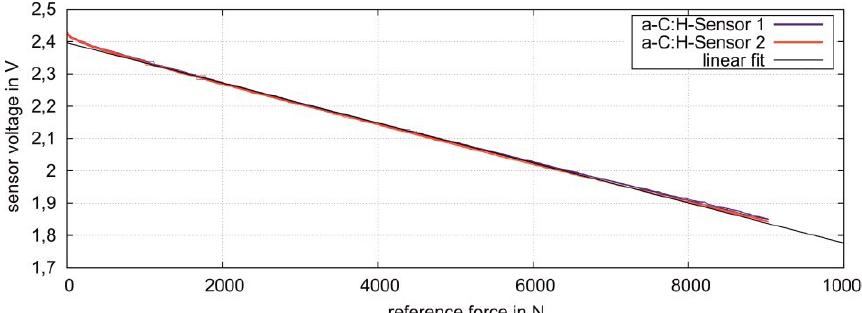
Figure 4. Load dependent characteristic of the measuring voltage transmitter by Bluetooth Low